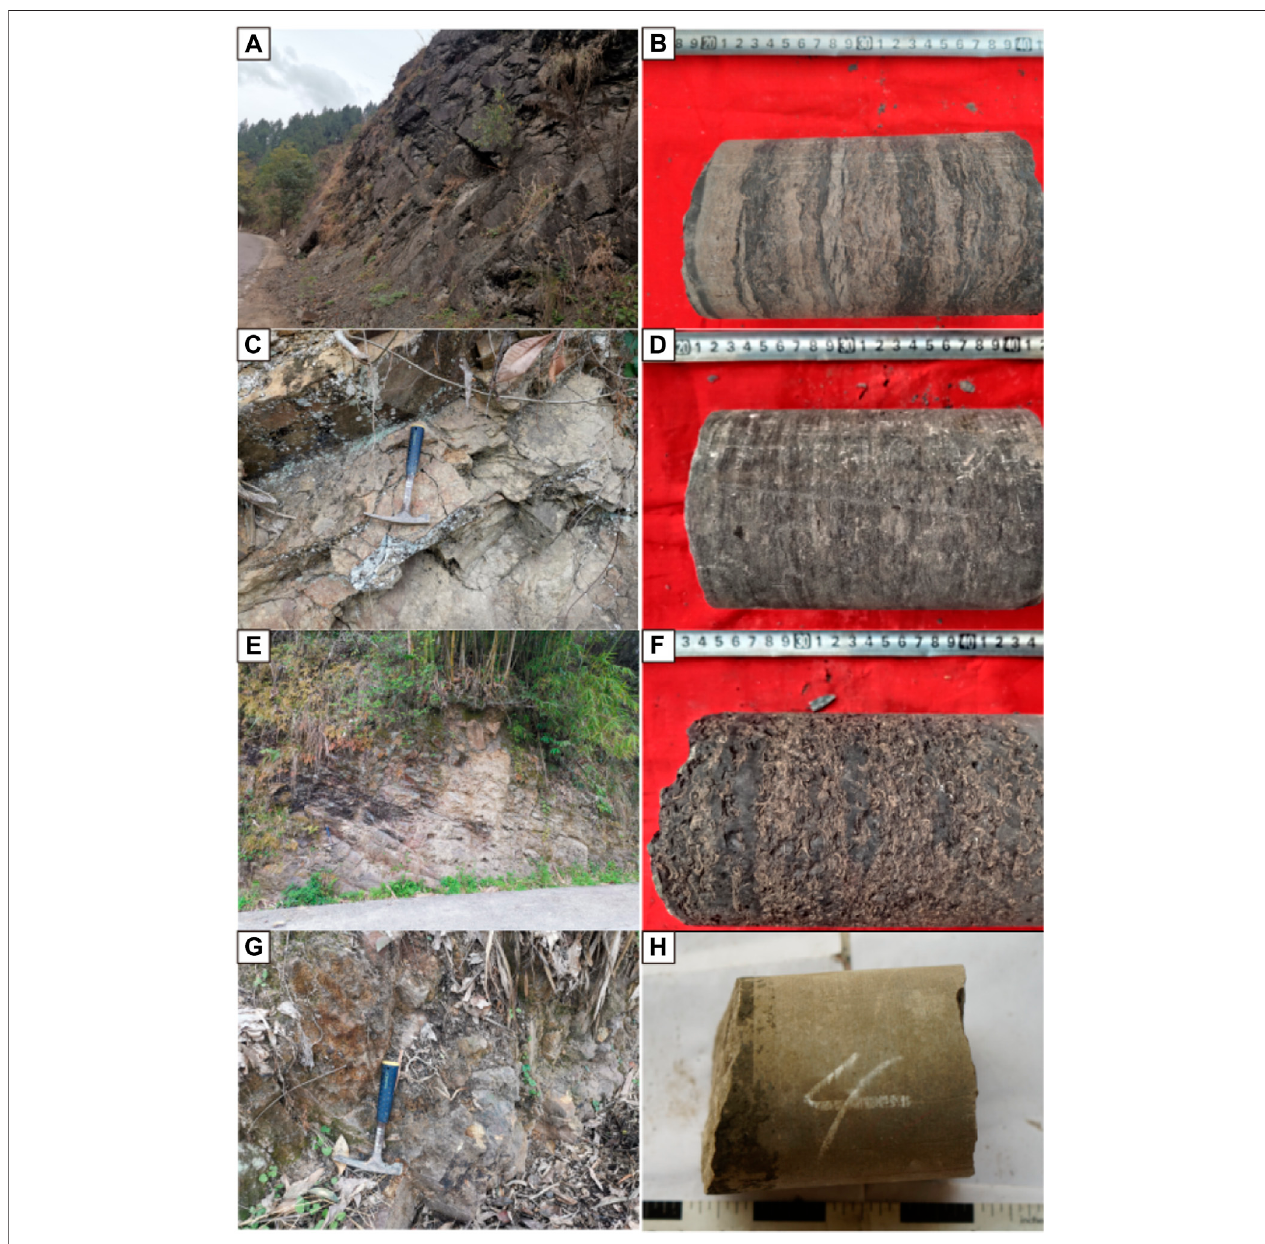
FIGURE2| Selectedoutcropanddrillingcorephotographstoshowthecharacteristics ofthelithologyinfourmembers. (A) Dark-graysandstoneinterbeddedwith shell mudstone, the Daanzhai member in the outcrop NX. (B) Dark-gray shell limestone, the Daanzhai member of the well KJ5 (drilling cores). (C) Medium- to thick- bedded,sandstone interbedded with dark-gray shale,theMaanshanmember inthe outcrop DB. (D) Dark-gray siltymudstone withshelldebris,the Maanshan member of the well CS1 (drilling cores). (E) Thin-bedded, dark-gray shale intercalated with light-gray to gray sandstone, the Dongyuemiao member in the outcrop HX. (F) Blackshaleinterbeddedwithshelldebris,theDongyuemiaomemberofthewellKJ6(drillingcores). (G) Medium-tothick-bedded,light-graysiltstone,theZhenzhuchong memberintheoutcropXL. (H) Thelight-graysiltstoneoftheZhenzhuchongmember ofthewellFD1(drillingcores).Pleasesee Figure1B foroutcrop andwelllocations.